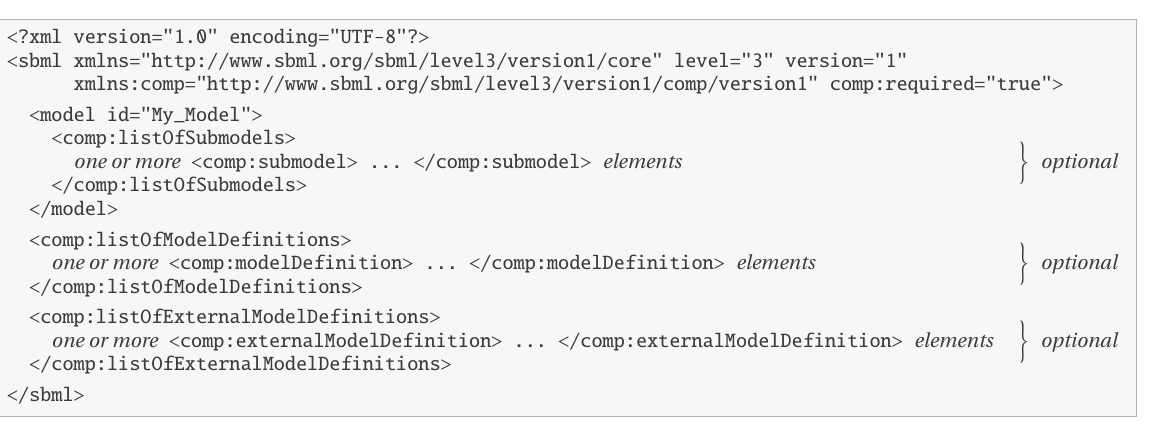
Figure 3: Skeleton document containing the possible top-level constructs of the Hierarchical Model Composition